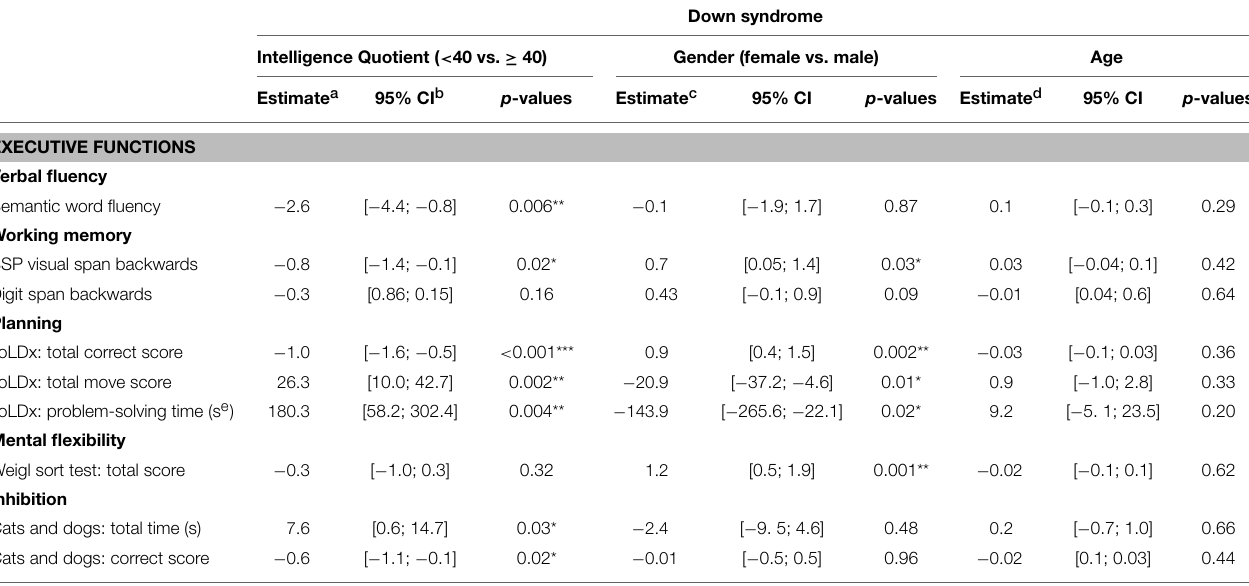
TABLE 4 | Impact of intellectual quotient (IQ), gender, and age on executive functioning in Down syndrome